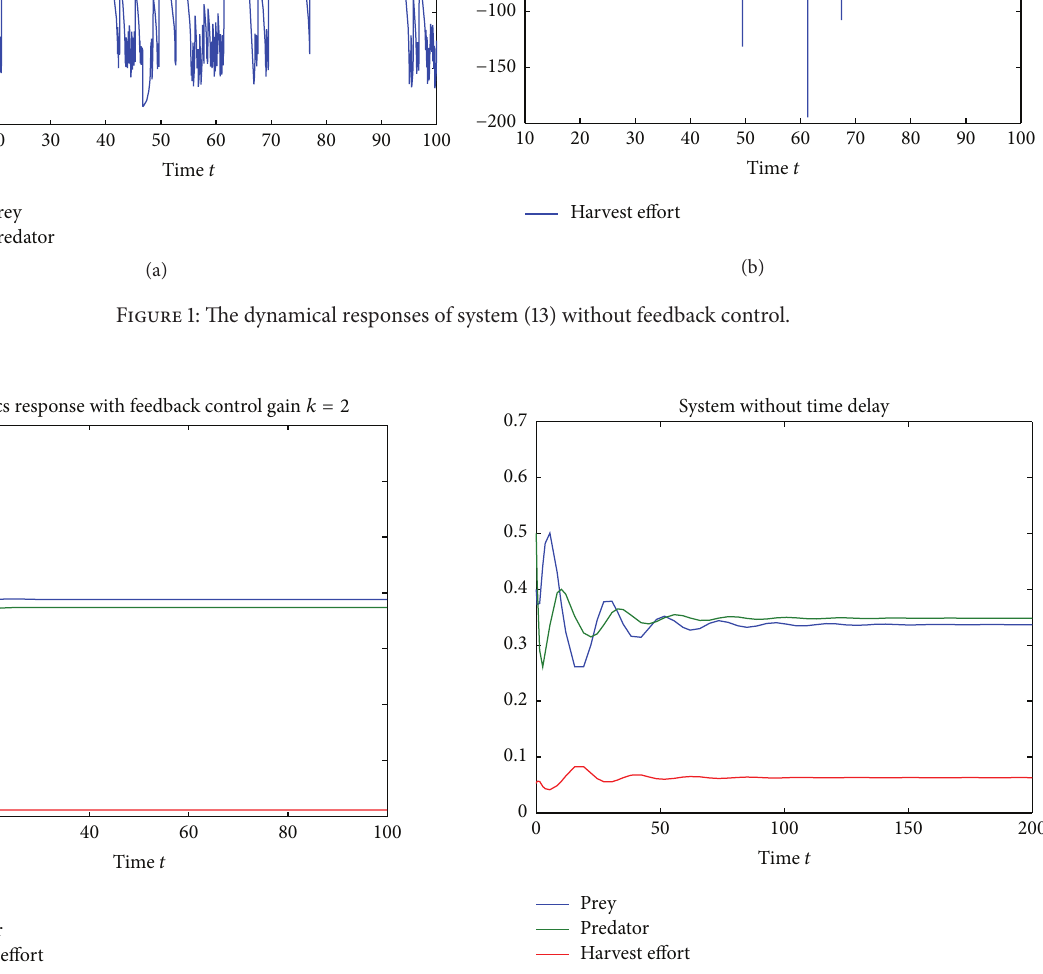
Figure 2: The dynamical responses of harvest effort of system (24) with feedback control.